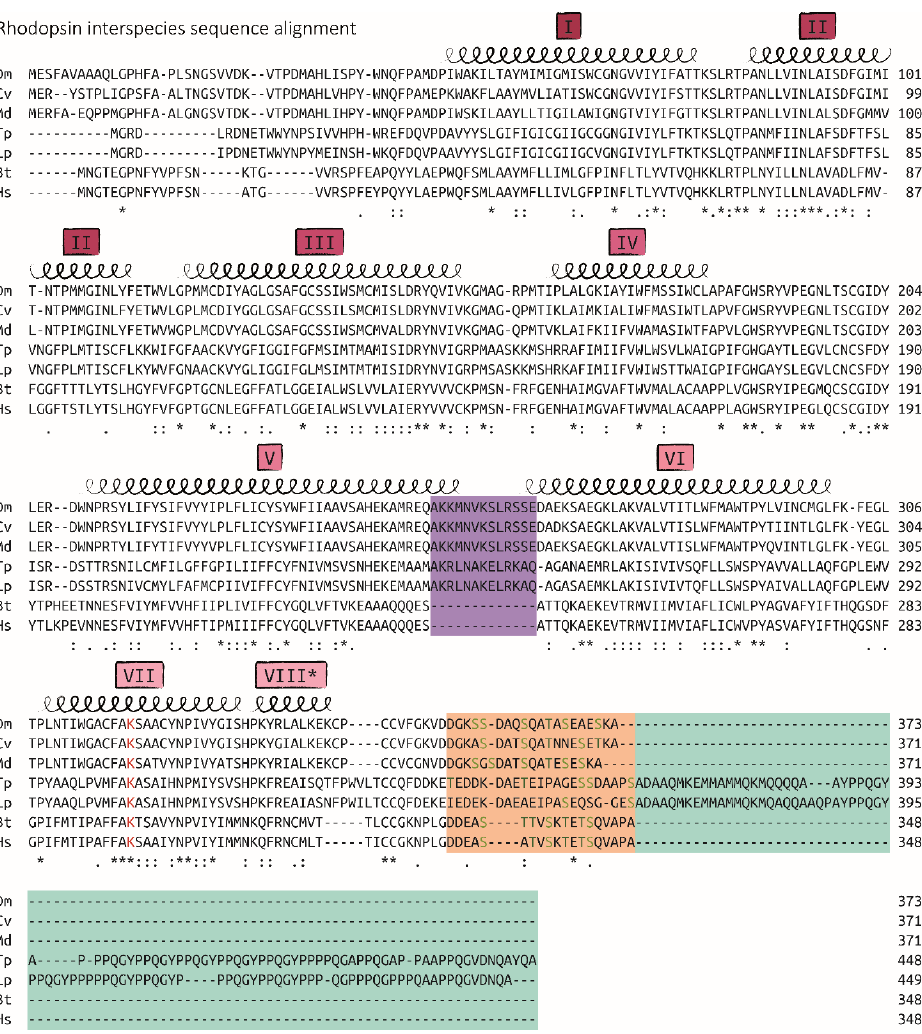
Figure 3. Structure and sequence comparison of rhodopsin from various species of invertebrates and vertebrates. Multiple sequence alignment of rhodopsin from invertebrate (three fly, two squid species) and vertebrate (cattle, human) species mainly discussed in this article and abbreviated as Dm: Drosophila melanogaster , Cv: Calliphora vicina , Md: Musca domestica , Tp: Todarodes pacificus , Lp: Loligo pealeii , Bt: Bos taurus , Hs: Homo sapiens . Sequences are denoted in amino acid one letter codes, dashes represent gaps. Alignments were performed and similarities evaluated by EMBL -EBI Clustal Omega [34]. Consensus symbols are shown below the sequences: asterisks (*) indicate fully con- served residues, colons (:) indicate residues with strongly similar properties, periods (.) indicate residues with weakly similar properties. Spirals above the sequences depict regions that fold into α -helices and are numbered sequentially with roman numerals of the seven transmembrane helices (I–VII) of GPCRs. The eighth short helix (VIII *) is not membrane-spanning, but rather laterally membrane-associated. Helices V and VI are slightly longer than the others and extend from the membrane into the cytoplasm. This is more pronounced in invertebrate rhodopsin due to additional amino acid residues shaded with a purple background. The central lysine residue (K) in helix VII which forms a Schiff base with the chromophore retinal is indicated in red. Weakly conserved C- termini are shaded with an orange background and harbor serine (S, light green) and threonine (T, dark green) residues as putative phosphorylation sites. Cephalopod rhodopsins feature signifi- cantly longer proline-rich C-termini which are shaded with a cyan background.